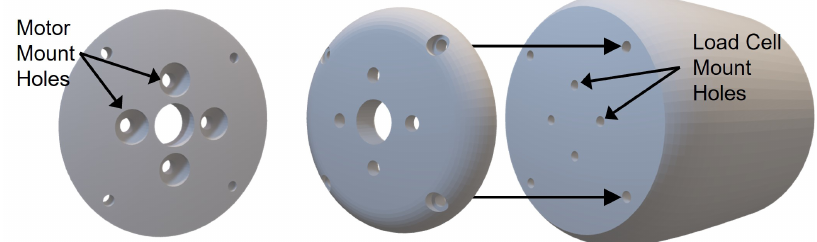
Figure 7. Motor mount backside ( left ) and cowling assembly ( right ).